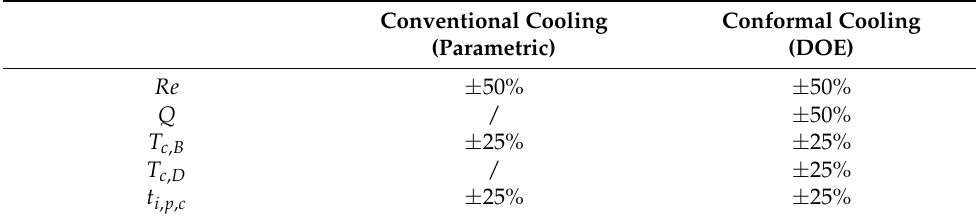
Table 5. Process variables and variable limits for parametric study of conventional cooling and DOE study of conformal